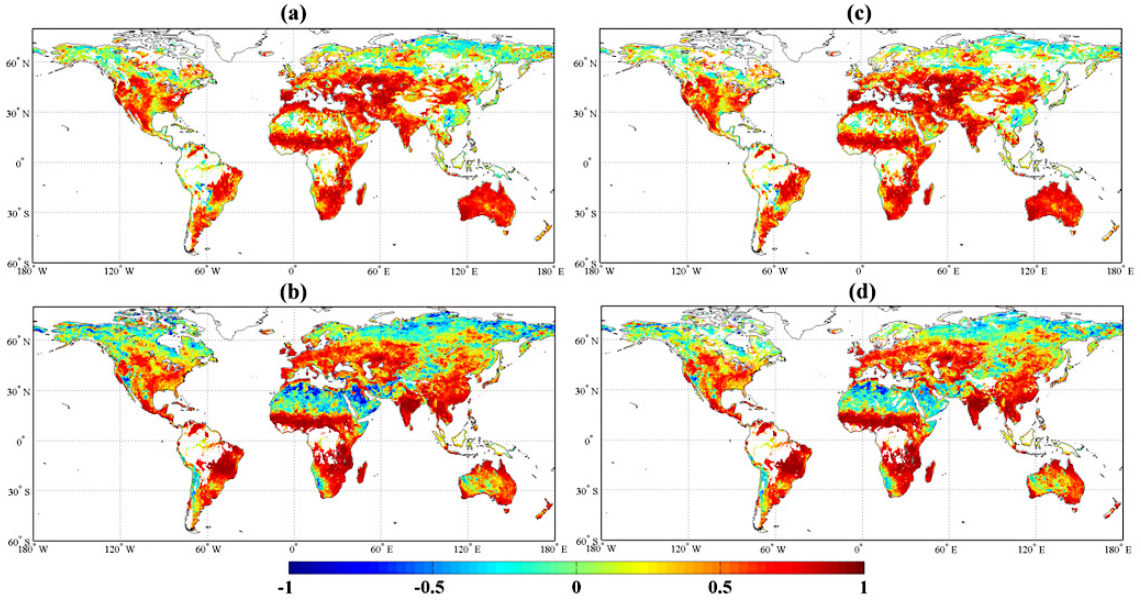
Fig. 4. Correlation coefficients (R) between Noah and (a) original AMSR-E, (b) original ASCAT, (c) rescaled AMSR-E and (d) rescaled ASCAT.